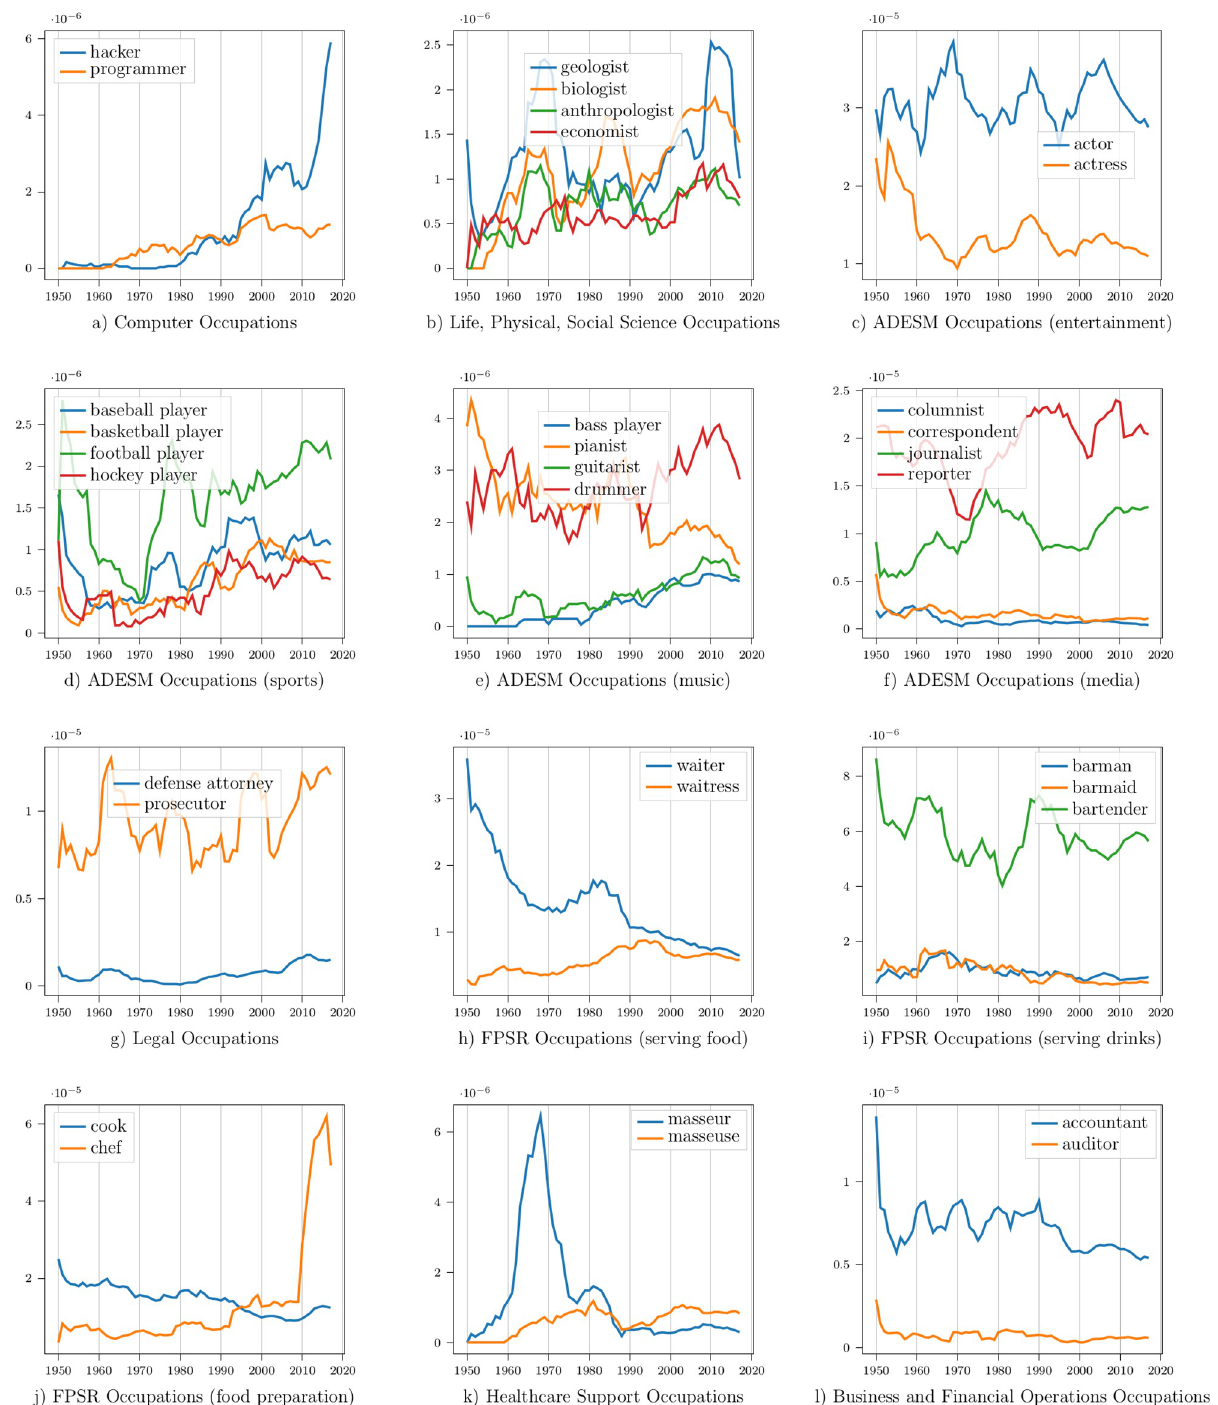
Fig 7. Frequency trends of different professions over time in media subtitles. ADESM = Arts, Design, Entertainment, Sports, and Media. FPSR = Food Preparation and Serving Related.